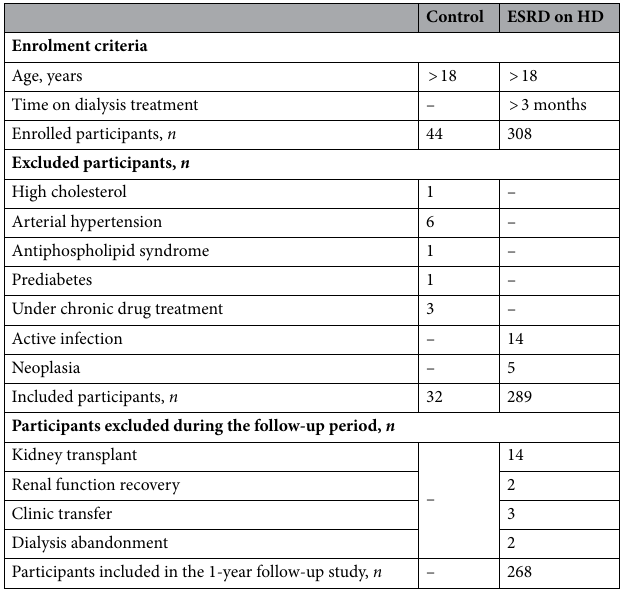
Table 1. Inclusion and exclusion criteria for controls and end-stage renal disease (ESRD) patients on hemodialysis (HD) treatment.